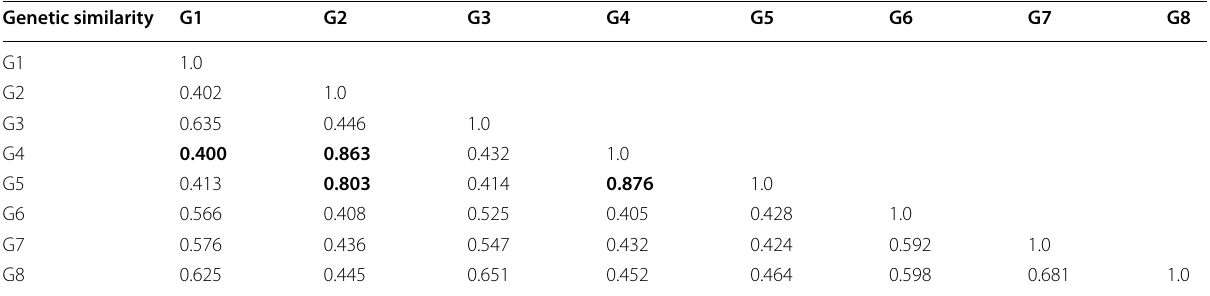
Bold values are very important values that are used in the case of important comparisons in the results and discussion parts